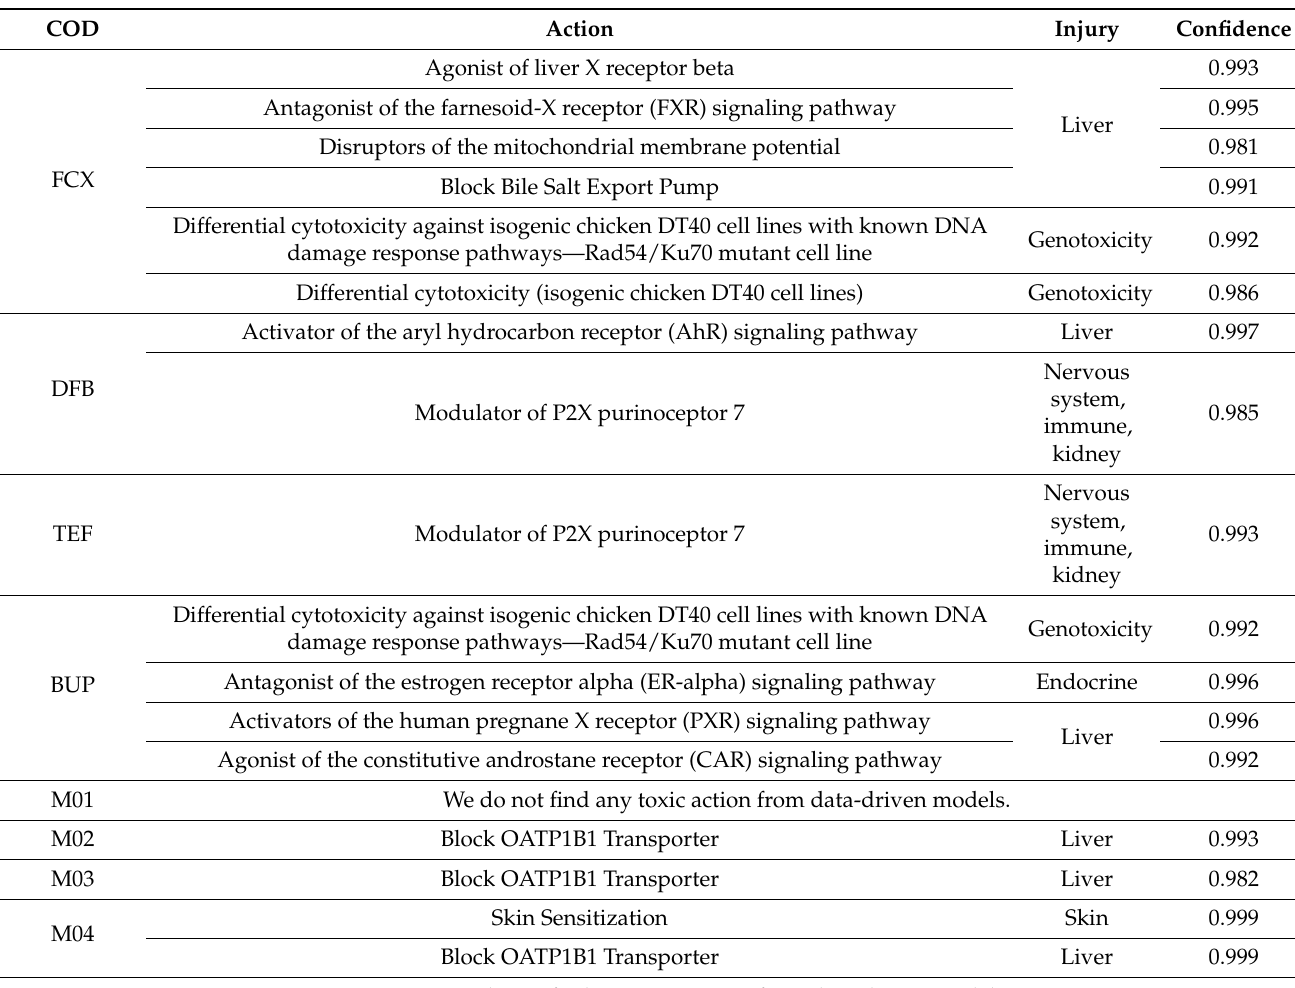
Table 4. Toxicological properties of selected molecules in the toxicity